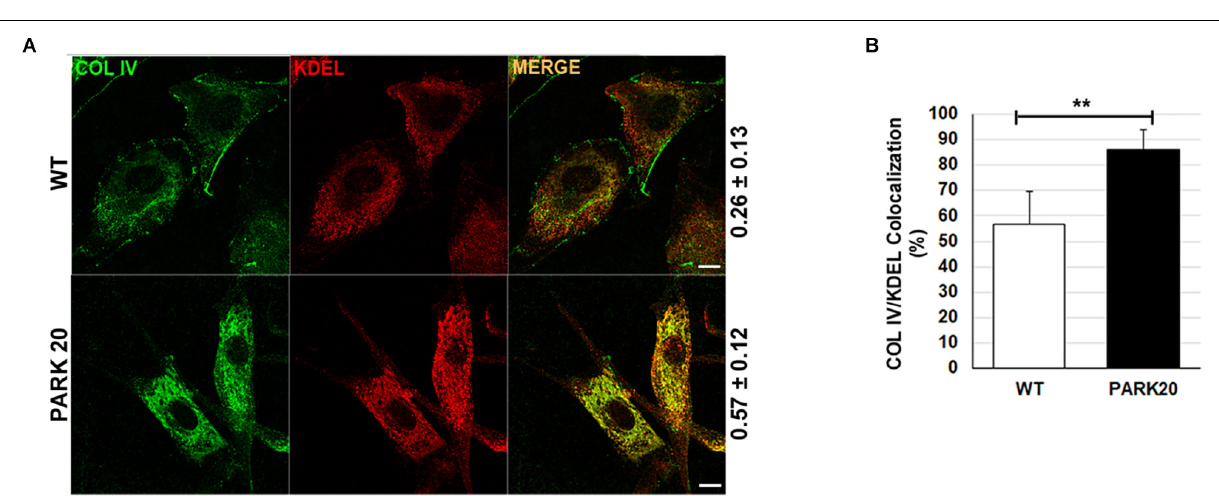
FIGURE 3 | The secretion of collagen IV is impaired in PARK20 fibroblasts. (A) HDF (WT) and PARK20 cells were seeded on glass coverslips, processed for immunofluorescence and analyzed by confocal imaging. Numbers on the right refers to Pearson’s correlation coefficient, quantified with Leica SP5